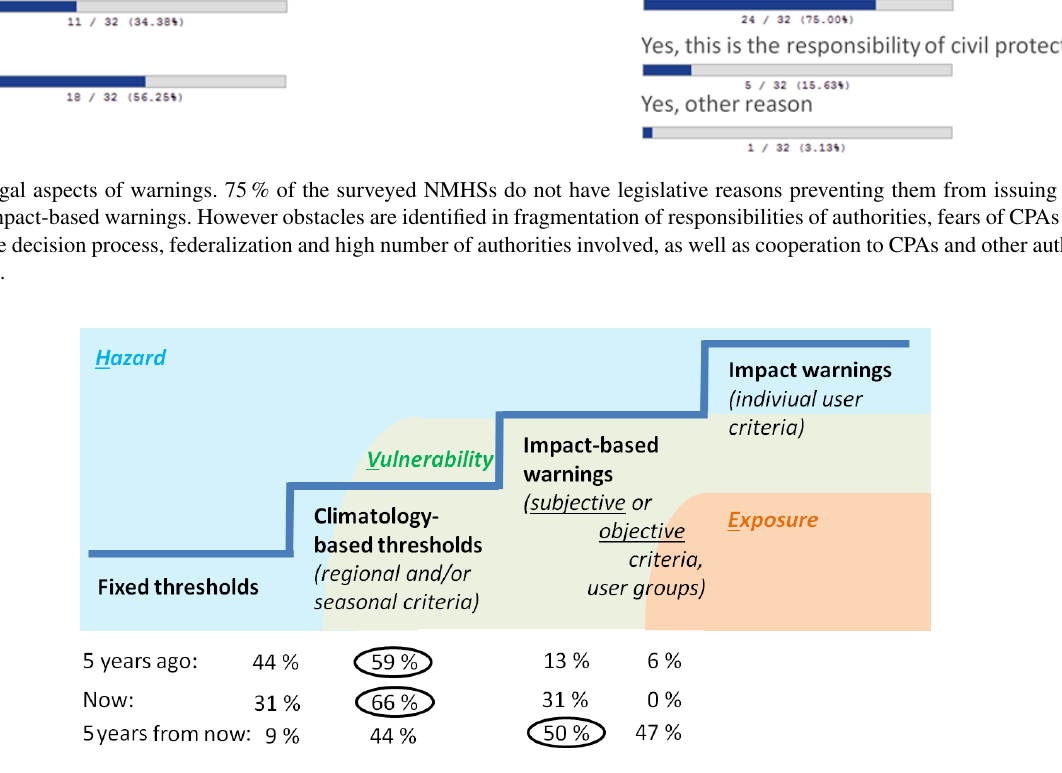
Figure 4. Evolution of public weather warnings, incorporating information on hazard, vulnerability and/or exposure. Warning criteria used at 32/37 European NMHSs participating in the EUMETNET Meteoalarm project 5 years ago, now (2018/2019) and 5 years from now. Maximum values marked with an ellipse. European NMHSs are currently in the transition phase from fixed thresholds or climatology-based thresholds to impact-based warnings based on subjective or objective